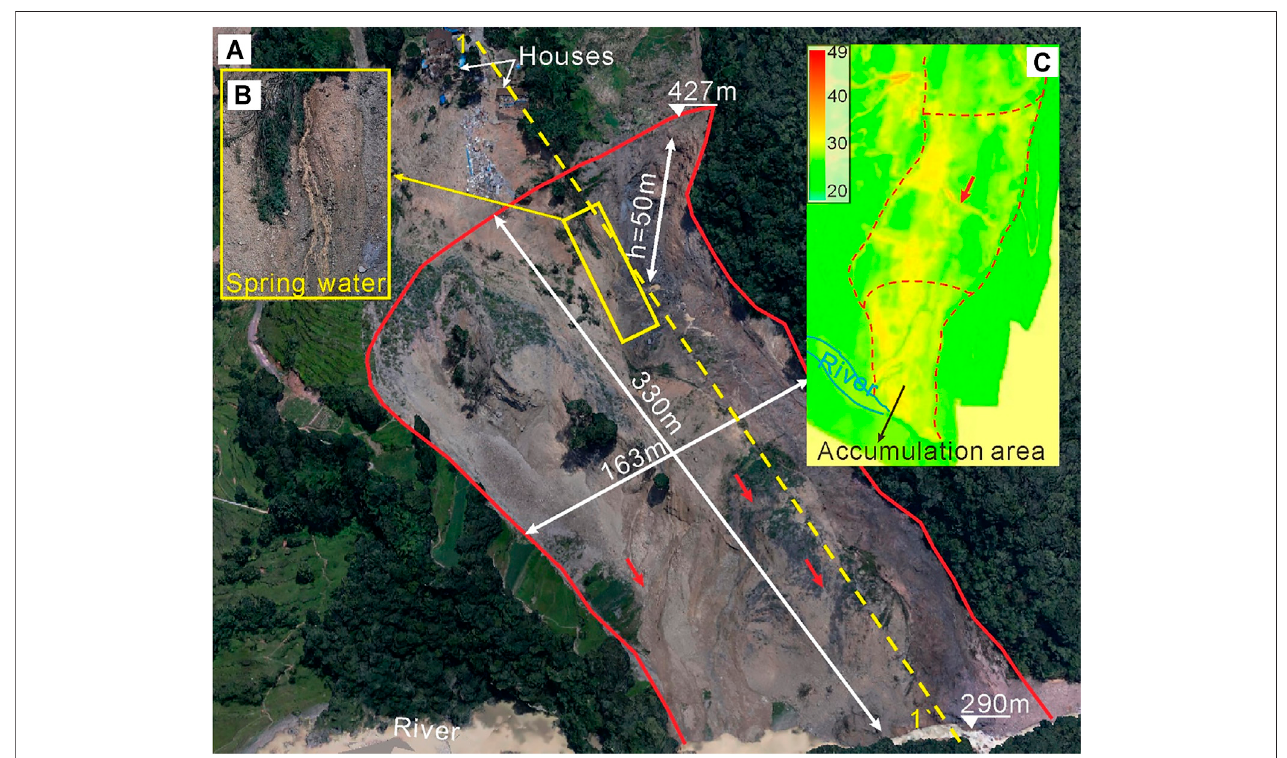
FIGURE 9 | Picture of accumulation area (A) , the spring water (B) , and the temperature of the landslide surface (C) .